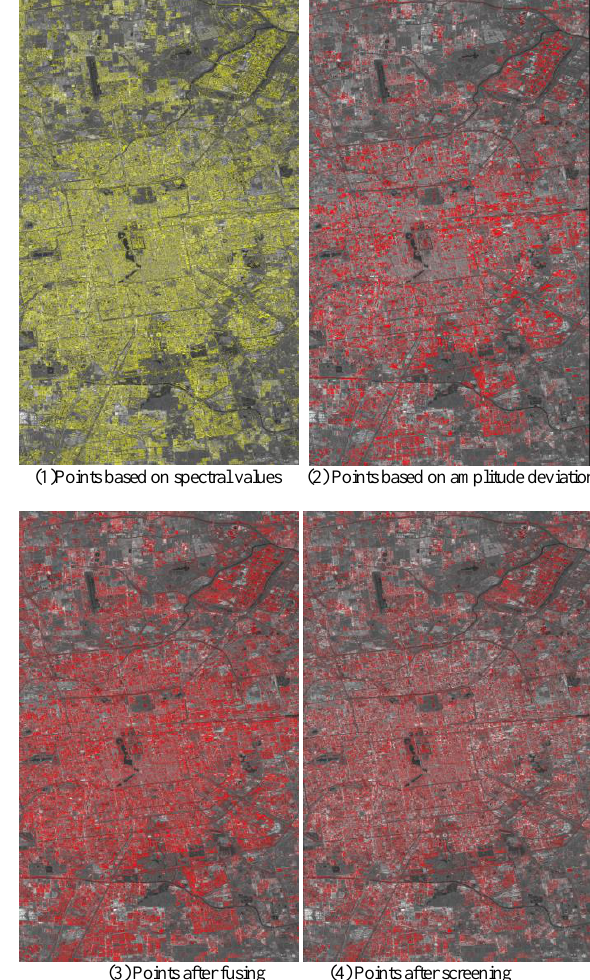
Figure 2. Result of Reference Point